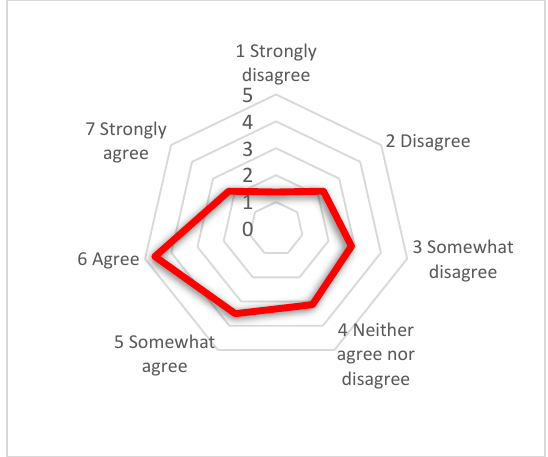
Figure 18. Manipulability assessment.